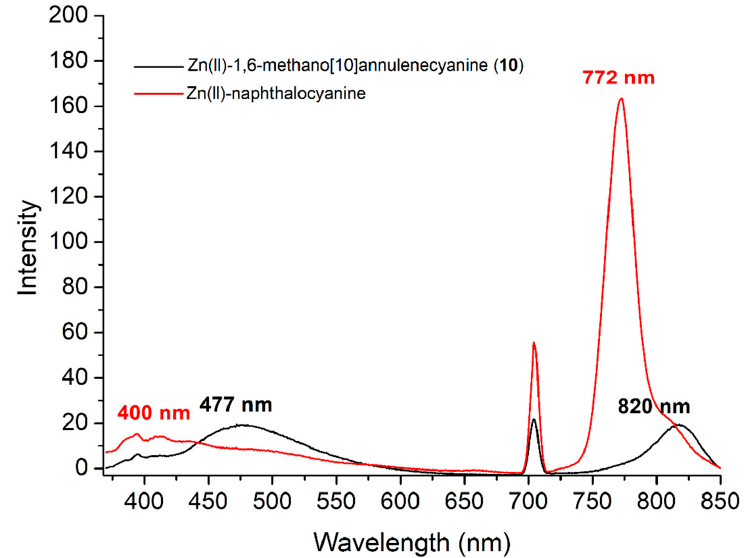
Figure 4. Emission spectra of compound 10 in comparison with standard Zn(II)-naphthalocyanine ( ZnNc ), both excited at 350 nm and analyzed in DMF.